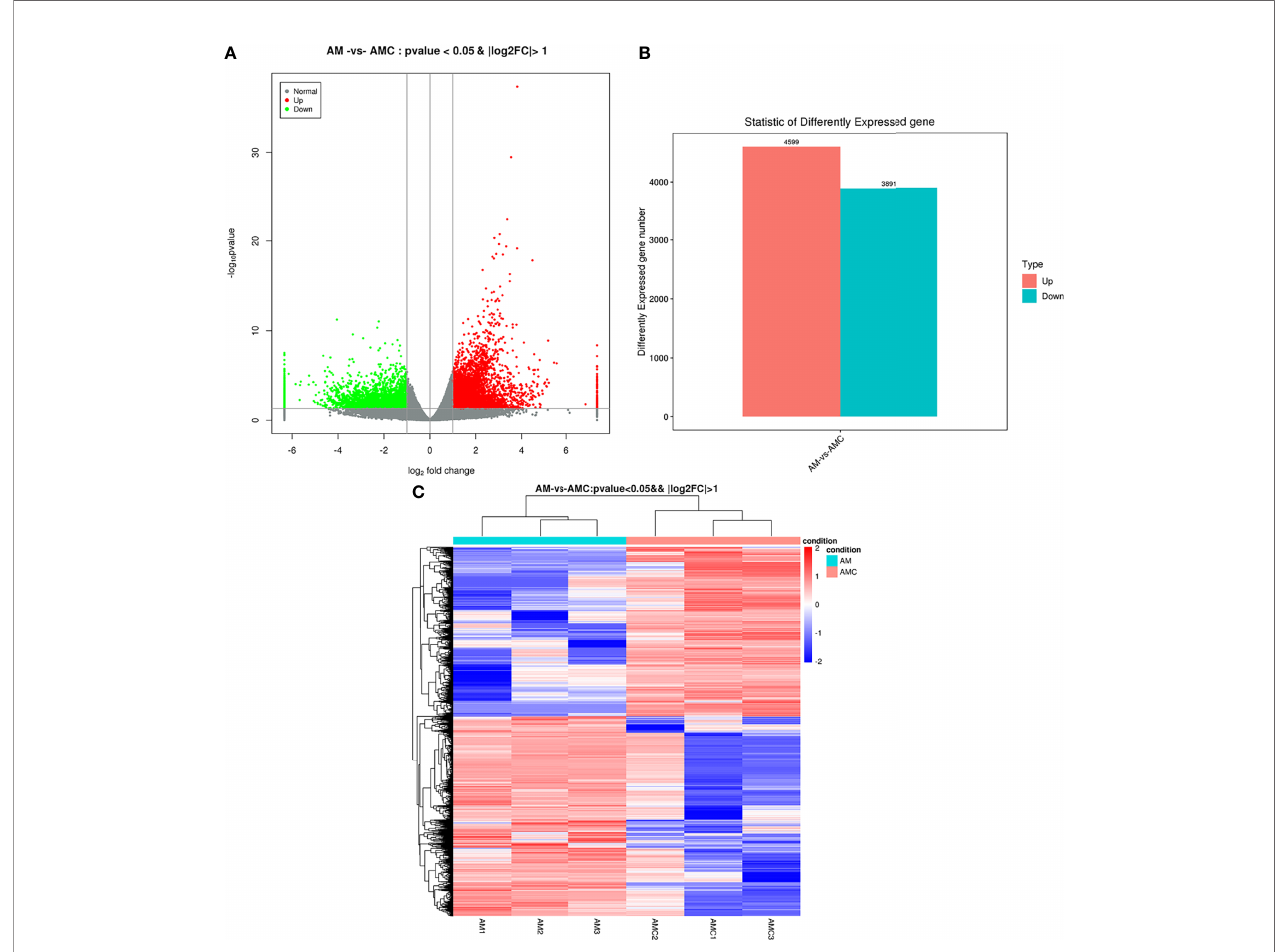
FIGURE 3 | Analysis results of differentially expressed genes. (A) Distribution of DEGs volcanoes. X-axis is the display of log2 foldchange, Y-axis is -log 10 P -value; Red represents upregulation unigene, green represents downregulation unigene, gray represents non differentiation unigene. (B) Statistical chart of the number of DEGs. The abscissa is DEGs, and the ordinate is the number of difference genes; Red represents upregulation unigene, green represents downregulation unigene. (C) Clustering diagram of different groups. Red indicates high expression of unigene and blue indicates low expression of